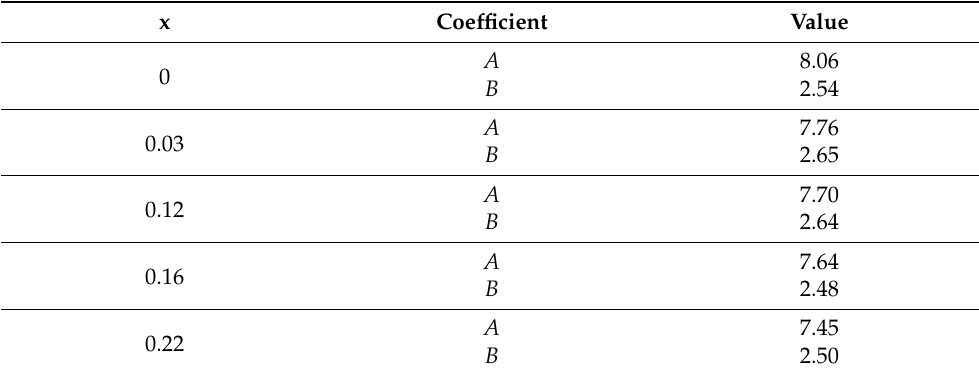
Table 1. Coefficients of expression (1) for GaSe:S crystals. x